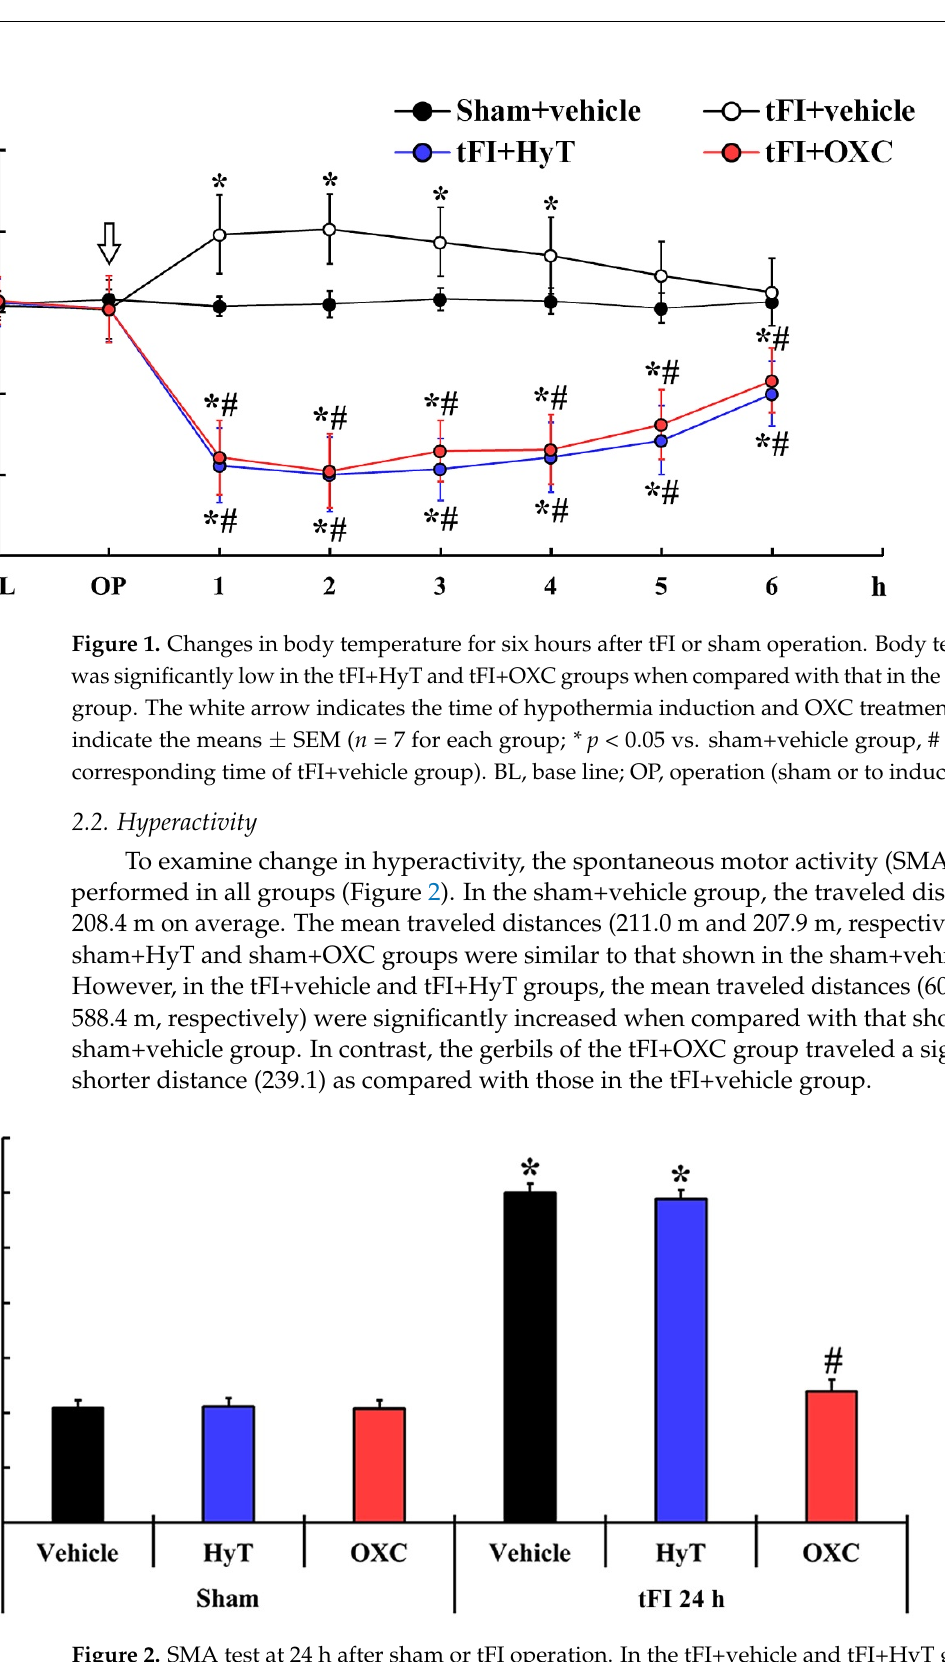
Figure 2. SMA test at 24 h after sham or tFI operation. In the tFI+vehicle and tFI+HyT groups, the mean traveled distances were significantly longer than that evaluated in the sham+vehicle group. In contrast, in the tFI+OXC group, the mean traveled distance was similar to that shown in the sham+vehicle group. The bars indicate the means ± SEM ( n = 7 for each group; * p < 0.05 vs. sham+vehicle group and # p < 0.05 vs. corresponding time of the tFI+vehicle